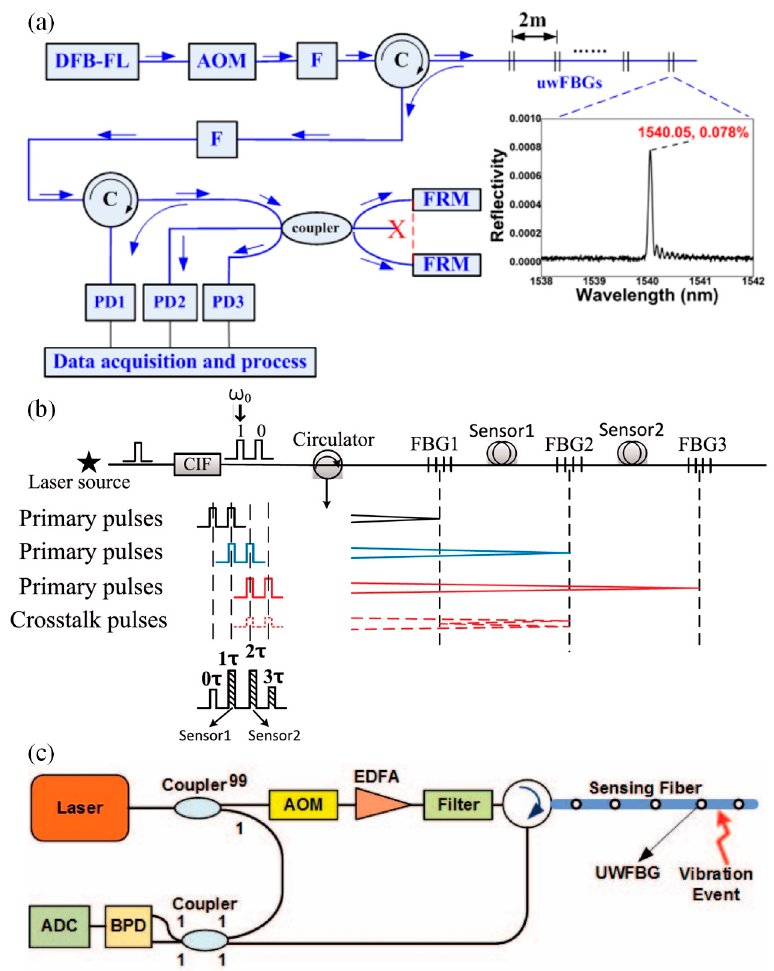
Figure 11. Representative DAS scheme based on UWFBG: ( a ) scheme using a 3 × 3 coupler [54]; ( b ) PGC scheme [55]; ( c ) heterodyne coherent detection scheme [29].